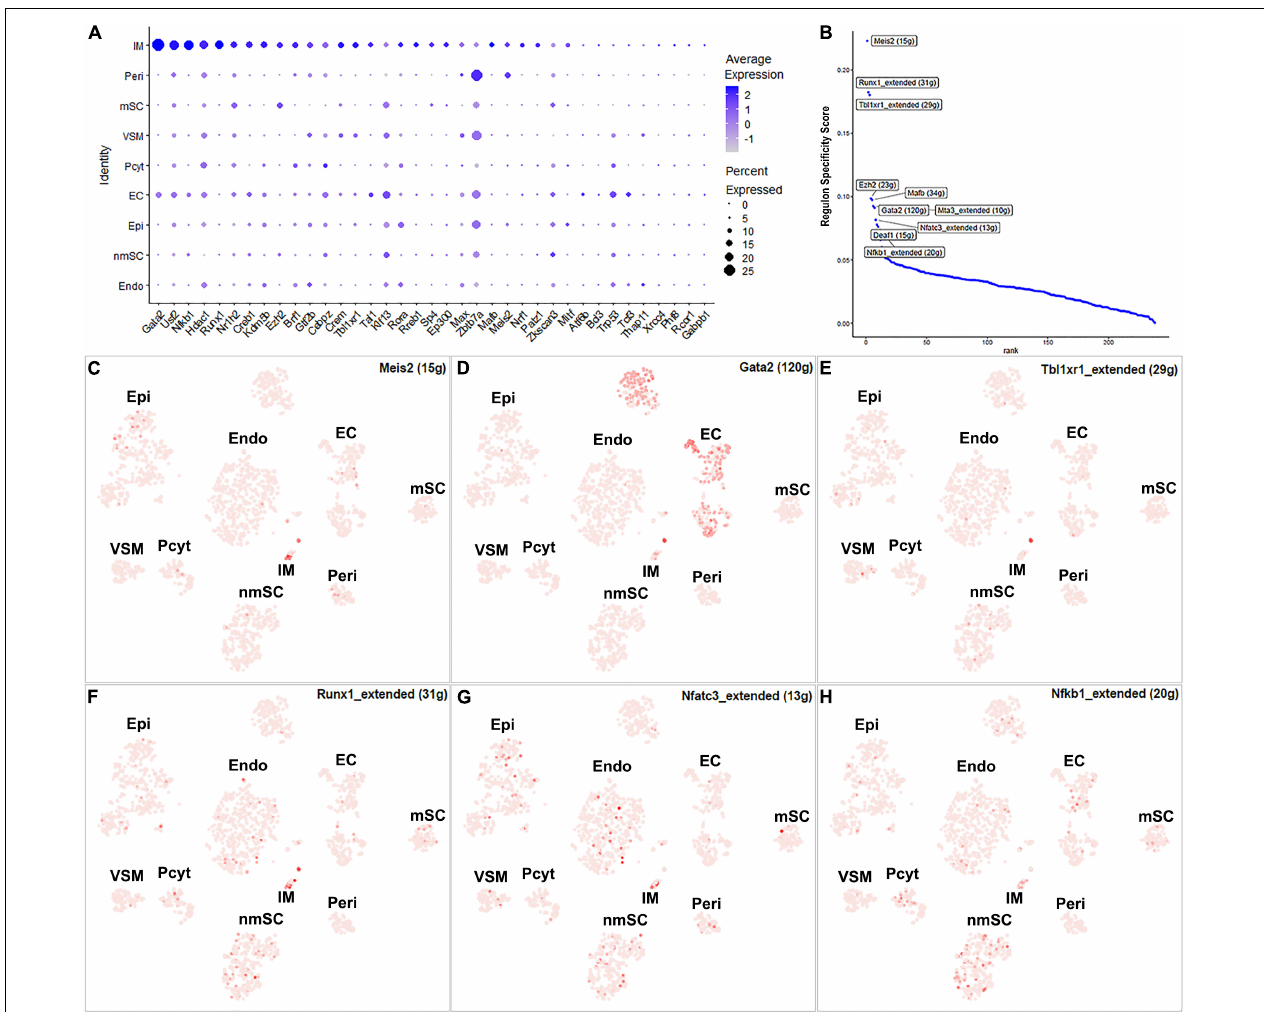
FIGURE 11 | TF activity in immune cells. (A) Thirty-seven identified TFs expressed in more than 5% of immune cells. (B) Regulon-specificity score in immune cells with top 10 specific TFs labeled. (C–H) The tSNE showing regulon activity for Meis2, Gata2, Tbl1xr1, Runx1, Nfatc3, and Nfkb1 in immune cells.